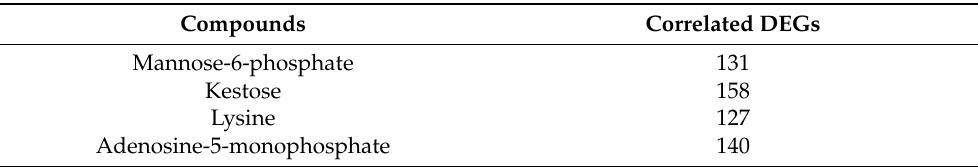
Figure 6. The heatmap of the correlation between differentially expressed genes (DEGs) and metabolites in C. albicans . Table 3. Some representative metabolites and significantly correlated differentially expressed genes (DEGs) of C. albicans between groups.